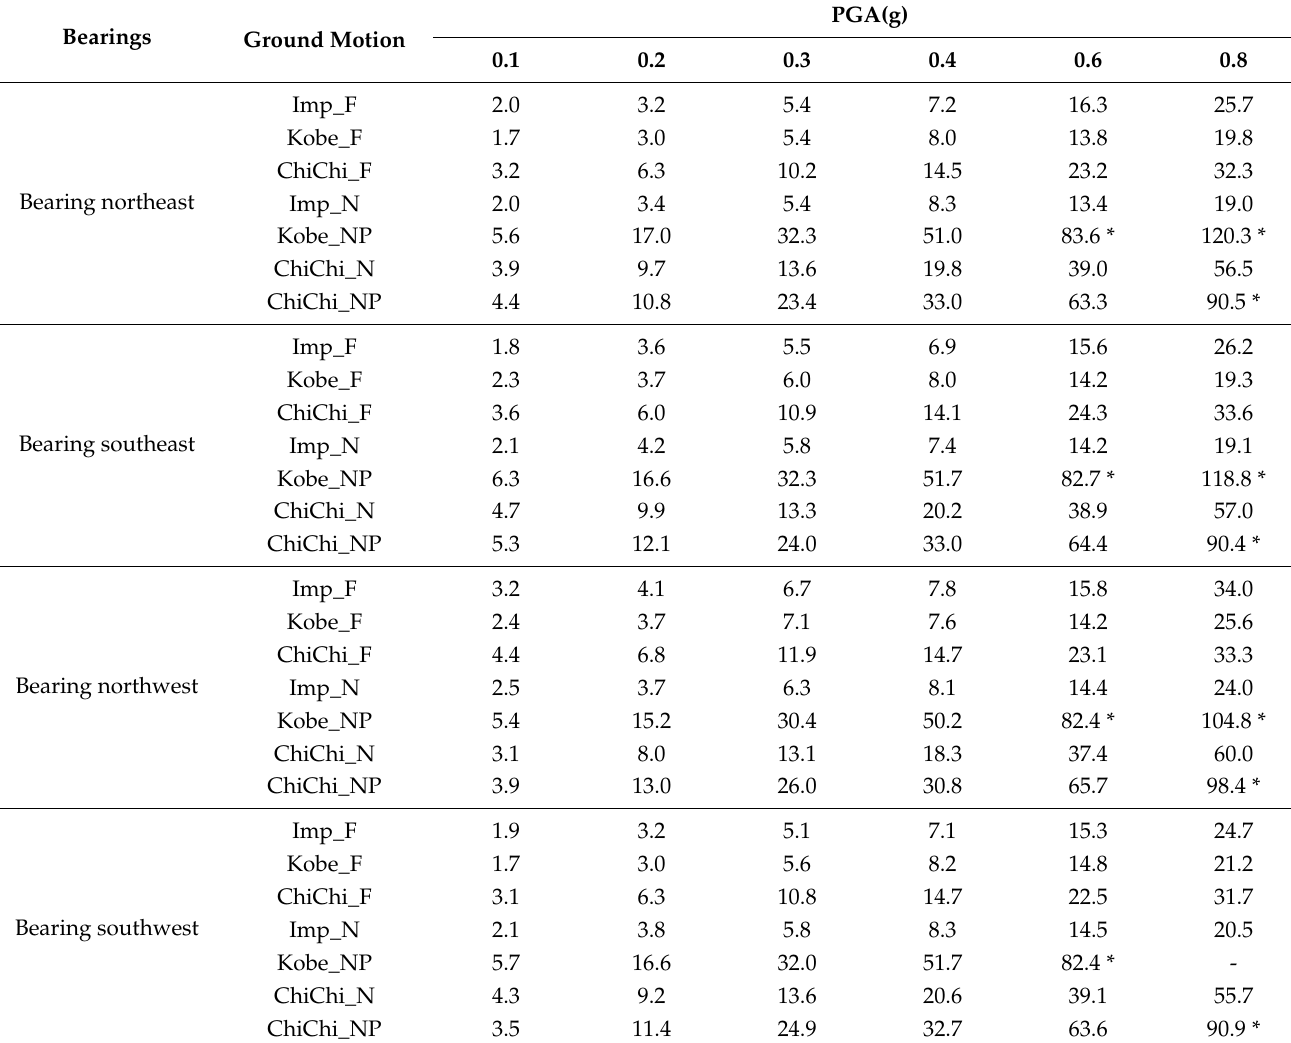
Table 8. Displacement of the bearings (unit: